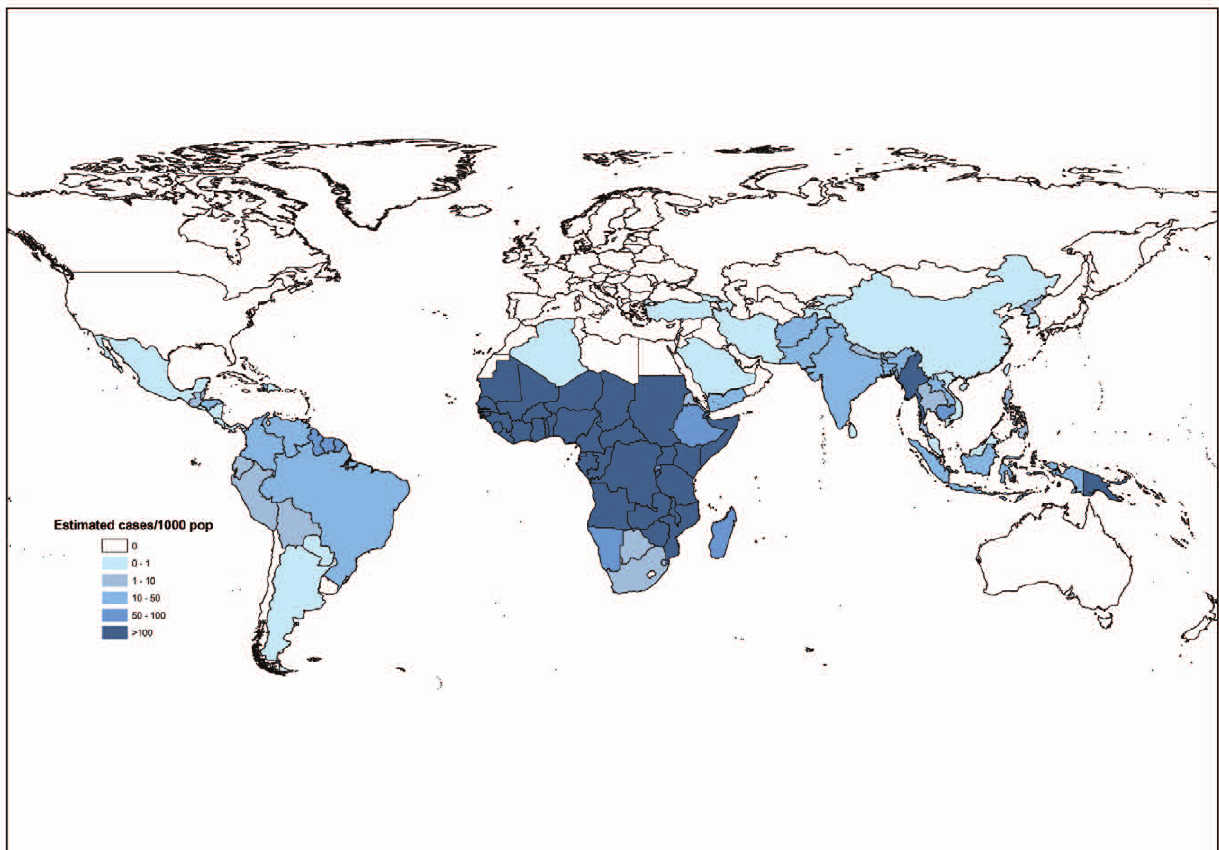
Figure 2. Estimated number of malaria cases per 1,000 population in 99 endemic countries made by method 1 (56 non-African and nine African countries) and method 2 (34 African countries).